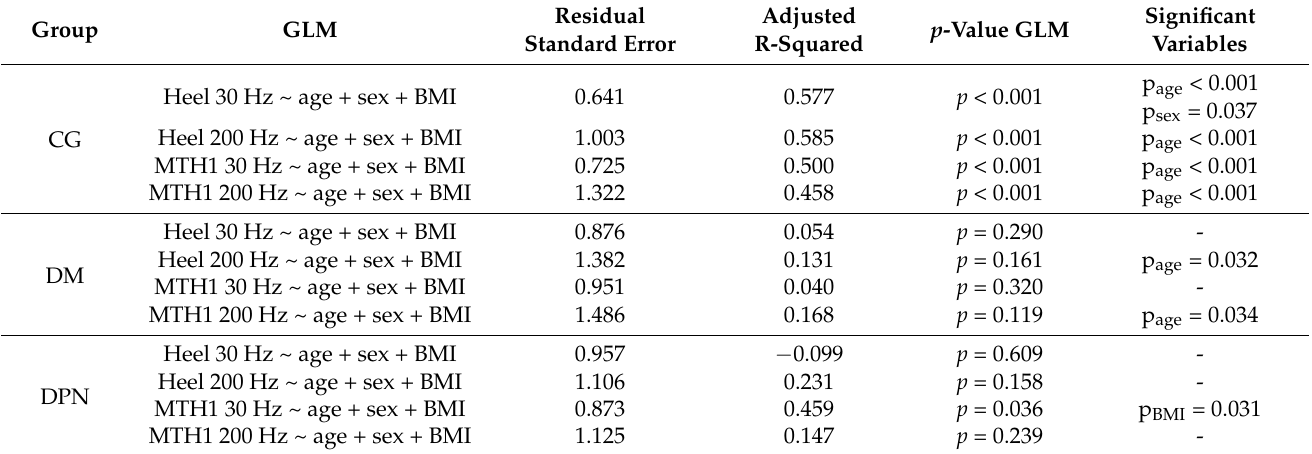
Figure A2. Comparisons between the two anatomical locations within a frequency and the frequency comparisons within an anatomical location were performed using t-tests for dependent samples. MTH1, first metatarsal head. Table A1. Output statistics of the calculated general linear